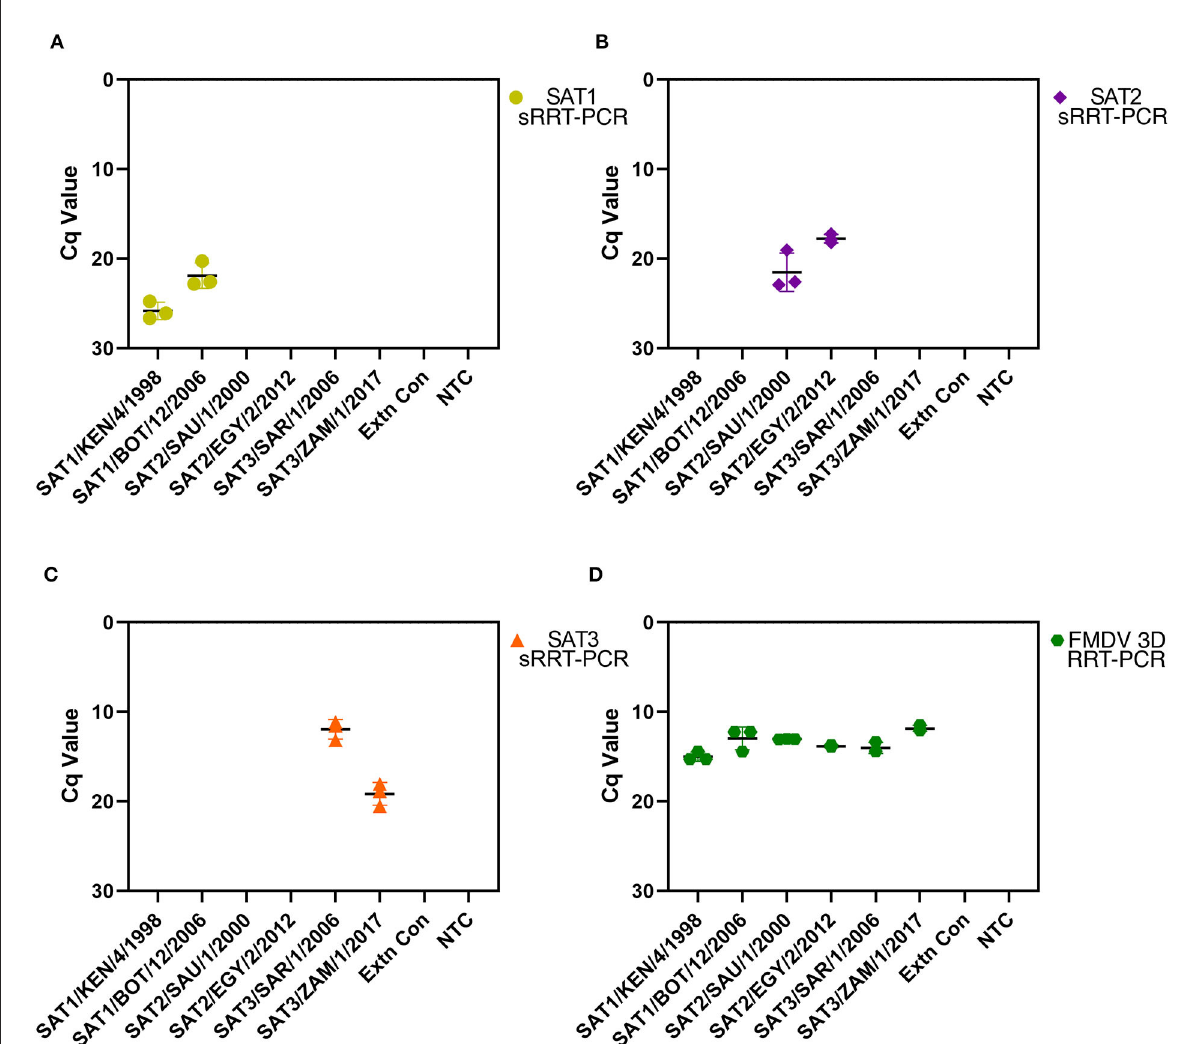
FIGURE1 Repeatability analysis for the FMDV SAT1, SAT2 and SAT3 assays. FMDV genomic RNA was extracted on three separate days from prototypic FMDV cell culture isolates SAT1/KEN/4/1998, SAT1/BOT/12/2006, SAT2/SAU/1/2000, SAT2/EGY/2/2012, SAT3/SAR/1/2006 and SAT3/ZAM/1/2017 as well as a PBS extraction control (Extn Con). Extracted RNA from each replicate was also analyzed using the SAT1 (A) , SAT2 (B), and SAT3 (C) srRT-PCR assays on three separate days. The FMDV 3D pan-serotype rRT-PCR assay (FMDV) was run in parallel with